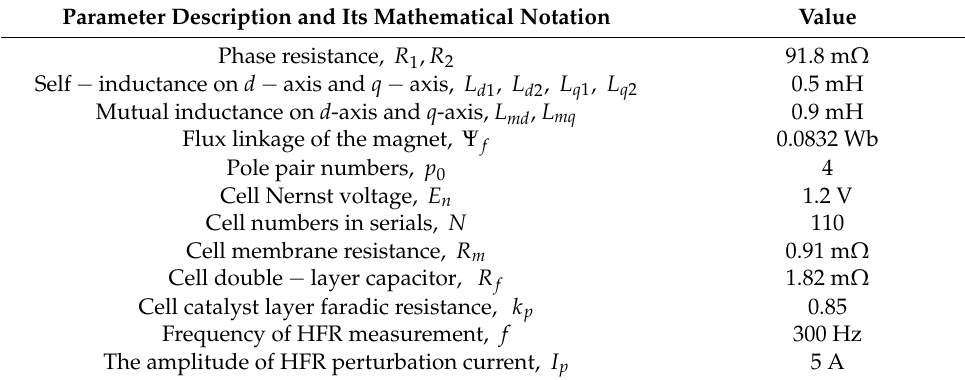
Figure 10. Overview of the system simulation model. Table 2. Simulation experiment parameters of DWM and PEMFC.